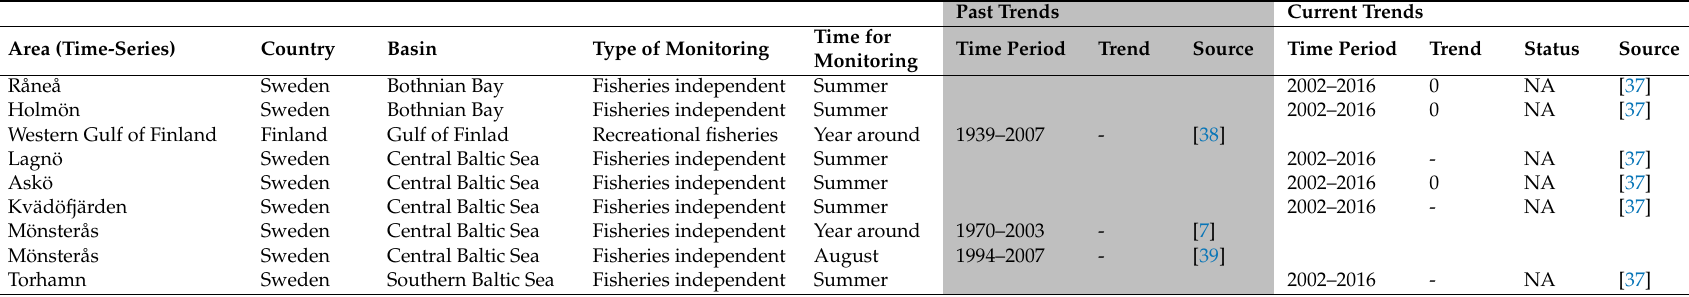
Table 3. Overview of the data and time-series used to assess past (data until the 2000s, grey columns) and current (data until the 2010s white columns) trends and status for pike. The columns “Source” refers to reference number